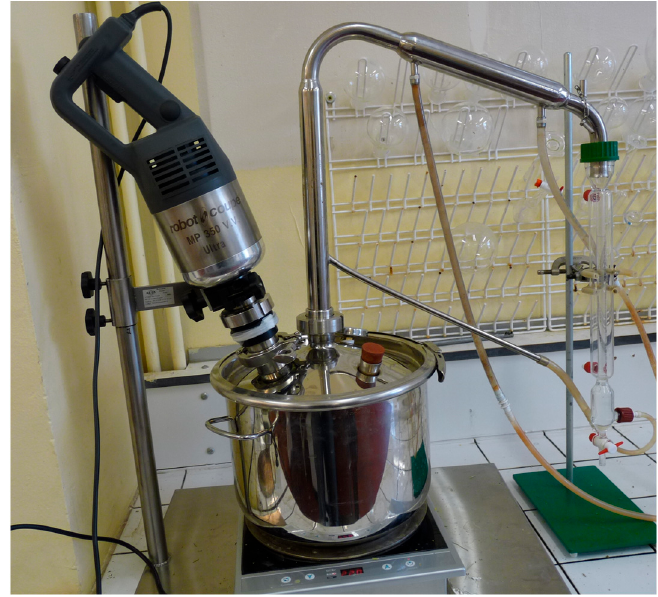
Figure 2. Extraction of essential oils by turbo